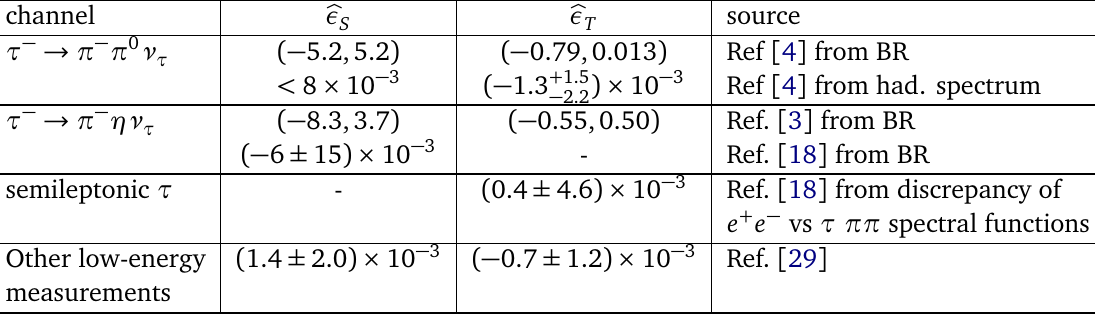
Table 3: Constraints on NS scalar and tensor couplings obtained from semileptonic tau decays compared to the better constraints available from other beta